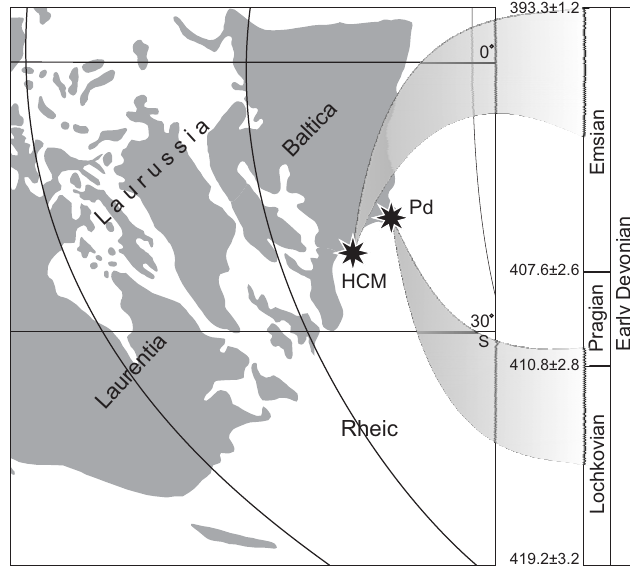
Fig. 6. Palaeogeographic reconstruction during the Early Devonian (after Domeier and Torsvik 2014) and stratigraphic occurences of the “Polish Placoderm Sandstone” and the Ukrainian “ Kujdanowiaspis series” in Podolia. Abbreviations: HCM, Holy Cross Mountains; Pd,